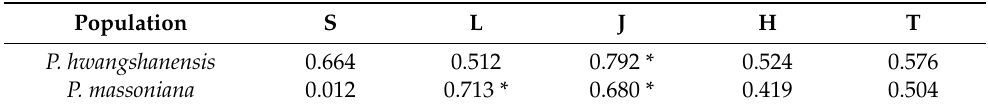
Table 2. Pearson correlation coefficients between calcium and magnesium concentrations in the needles of P. massoniana and P. hwangshanensis .